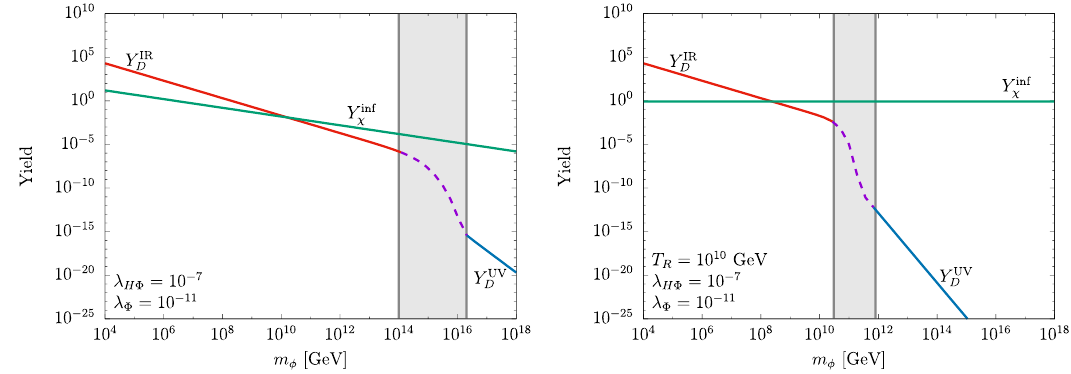
(red), Y UV (green) and Y inf (blue) χ D D = 10 10 GeV . The IR and UV freeze-in are R . m . 100 T R φ R